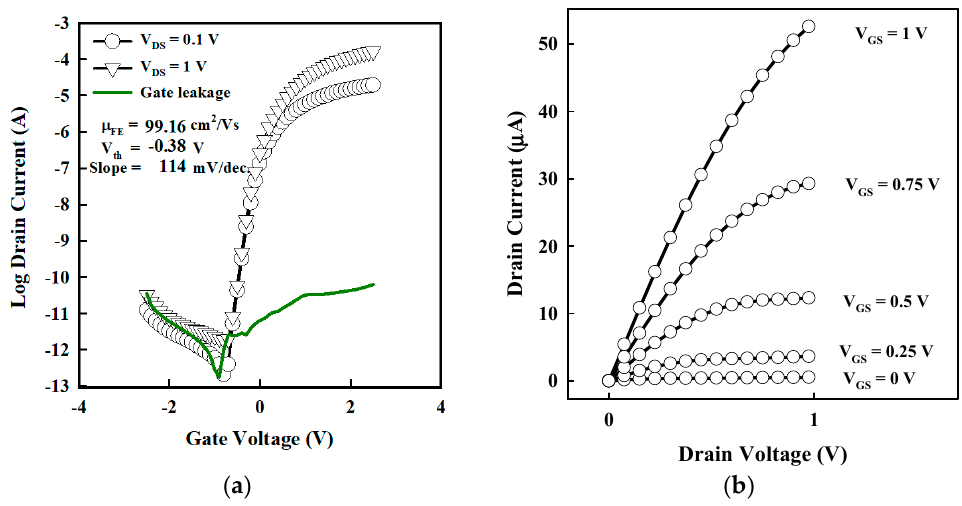
Figure 4. Electrical characterization of a-SnO x TFT. Typical ( a ) transfer and ( b ) output of a TFT using HfO 2 as the gate insulator. For the transfer curve, V DS = 0.1 and 1 V are shown in dark lines with symbols. The green line is the gate leakage. For the output curves, V DS was varied from 0 to 1 V, and V GS was set from 0–1 V.